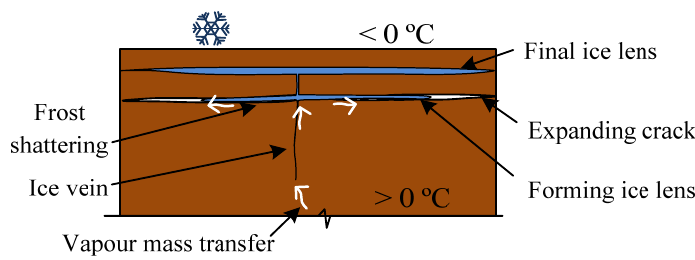
Figure 2. Soil sample structure at the different stages of freezing: ( a ) unfrozen equilibrium; ( b ) be- ginning of the freezing of ice lenses segregation; ( c ) further freezing or frost penetration; and ( d ) frost shattering and frost heave stage.